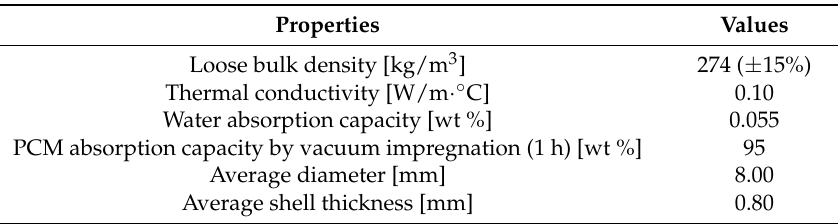
Figure 2. Measurement of ( a ) ME-LWA diameter and ( b ) ME-LWA coating thickness. Table 3. Properties of the impregnated and coated LWA.